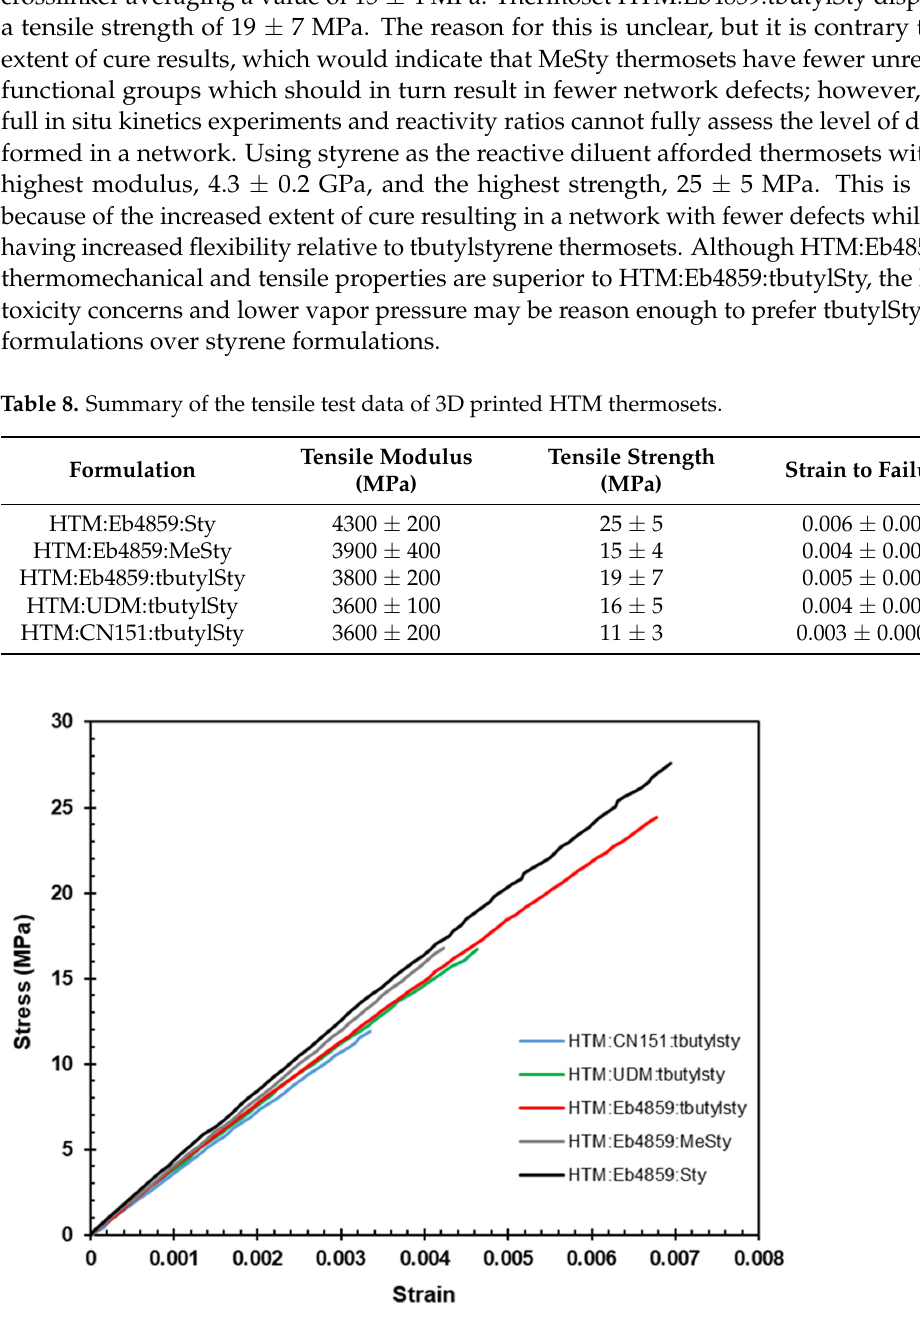
Figure 12. Representative stress–strain curve of 3D printed HTM thermosets. Table 8. Summary of the tensile test data of 3D printed HTM thermosets.